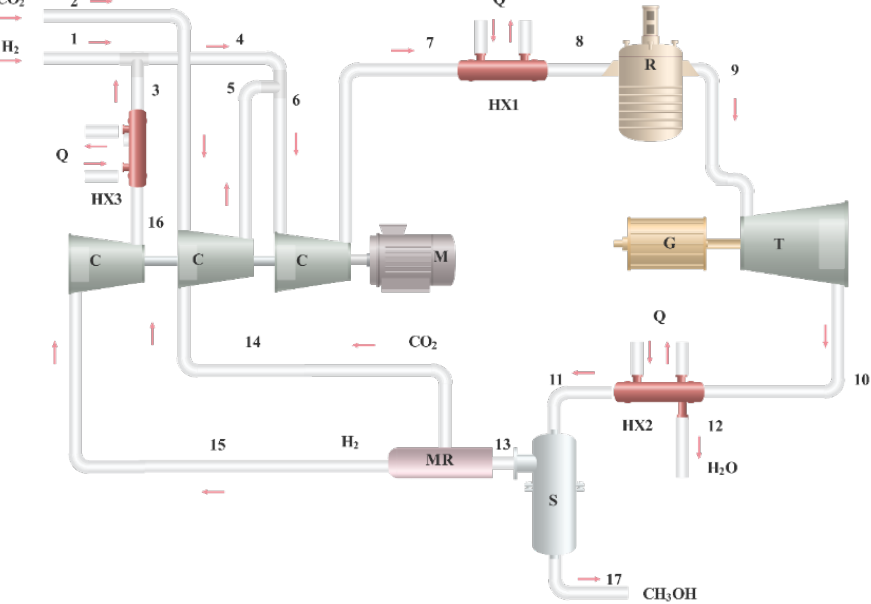
Figure 3. Installation of methanol production in the gas turbine cycle (C: compressor; HX-heat exchanger; T: gas turbine; R: methanol synthesis reactor; S: separator; MR: separation membrane; G: generator; M: motor; Q: heat; CO 2 : carbon dioxide; H 2 : hydrogen; H 2 O: water; CH 3 OH: methanol).